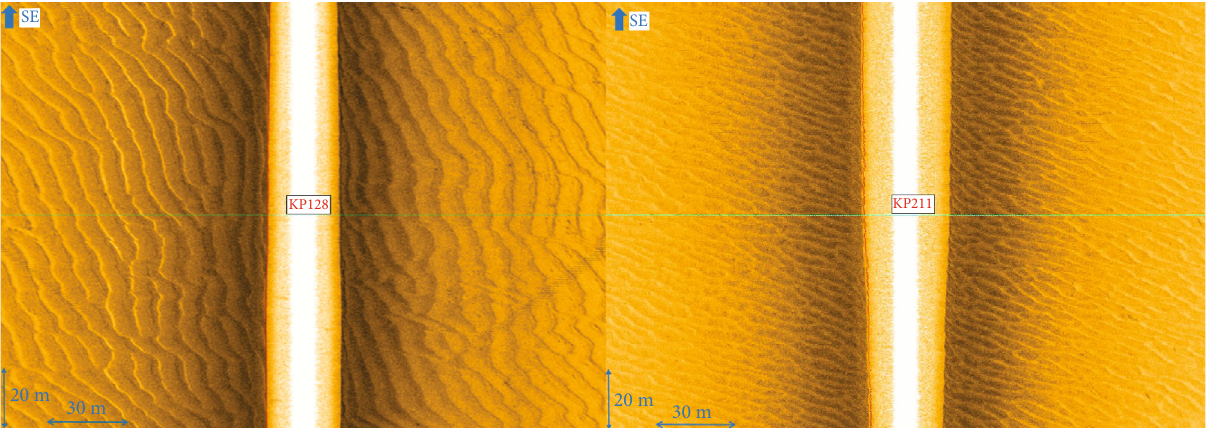
Figure 6: KPKP484km ~ KP638km routing topographic pro fi le.